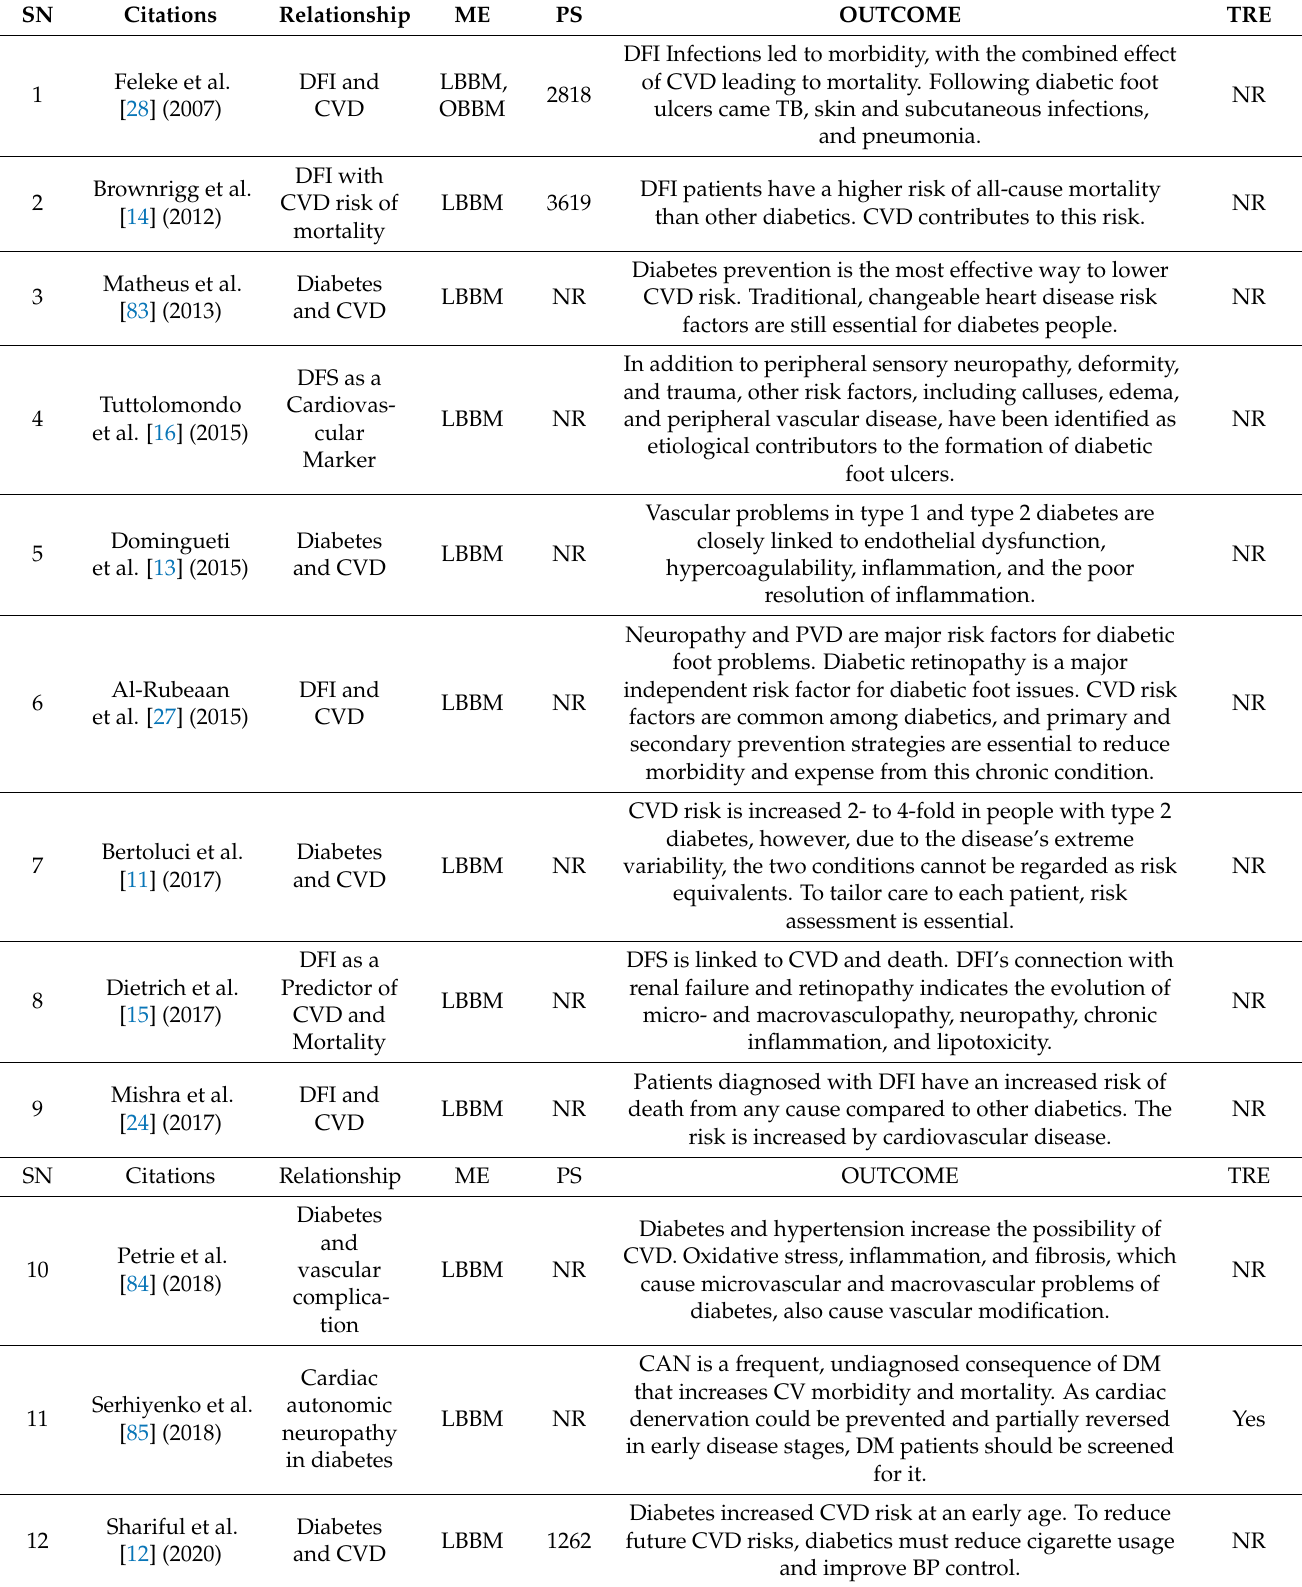
Table 1. Relationship between the diabetic foot, diabetic syndrome, and cardiovascular